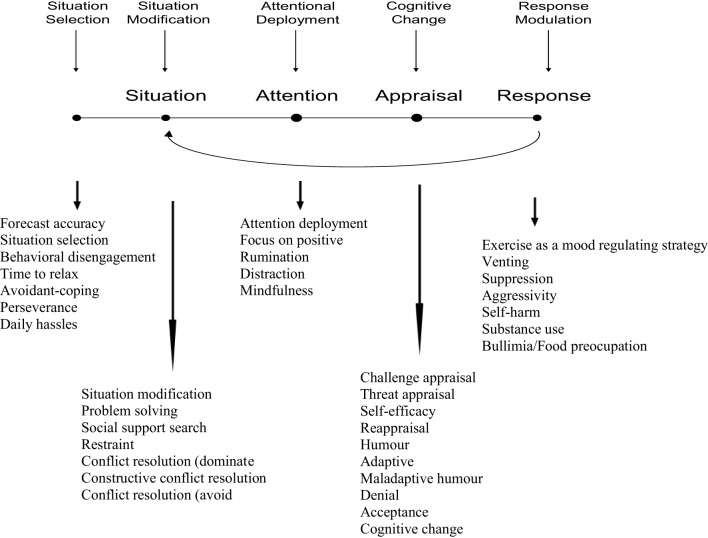
The process model of emotion regulation (Gross, 1998b, 2014).